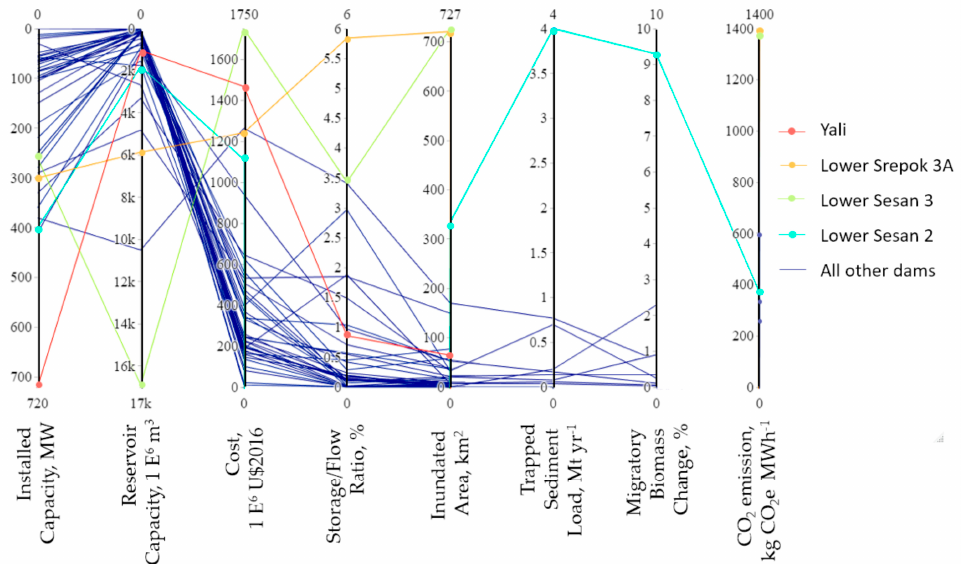
Figure 6. Parallel axis plot of tradeoffs among competing human and environmental objectives. Each axis represents a different objective with better performance at the bottom. Each line shows tradeoffs for different existing or planned dams. Environmental objectives are unavailable for some dams. Data for human objectives of installed capacity, storage capacity, and cost were from [2]. Environmental objectives and data sources include inundated area [2], Storage-flow ratio [17], average trapped sediment load [12], CO 2 e emissions per energy unit [44], and average change in migratory biomass [3].